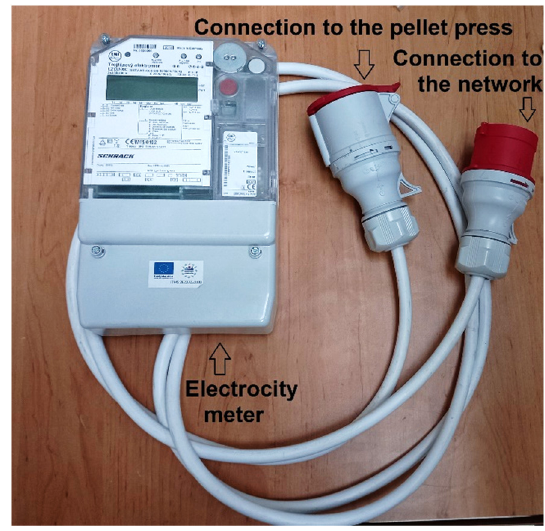
Figure 2. The used electricity meter.